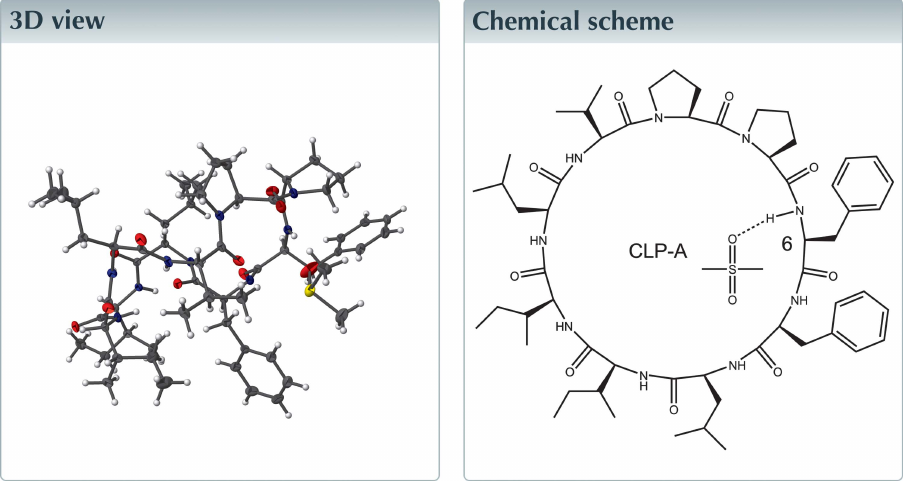
Fig. 2. The first crystal structure for CLP-A 2-propanol solvate was published by